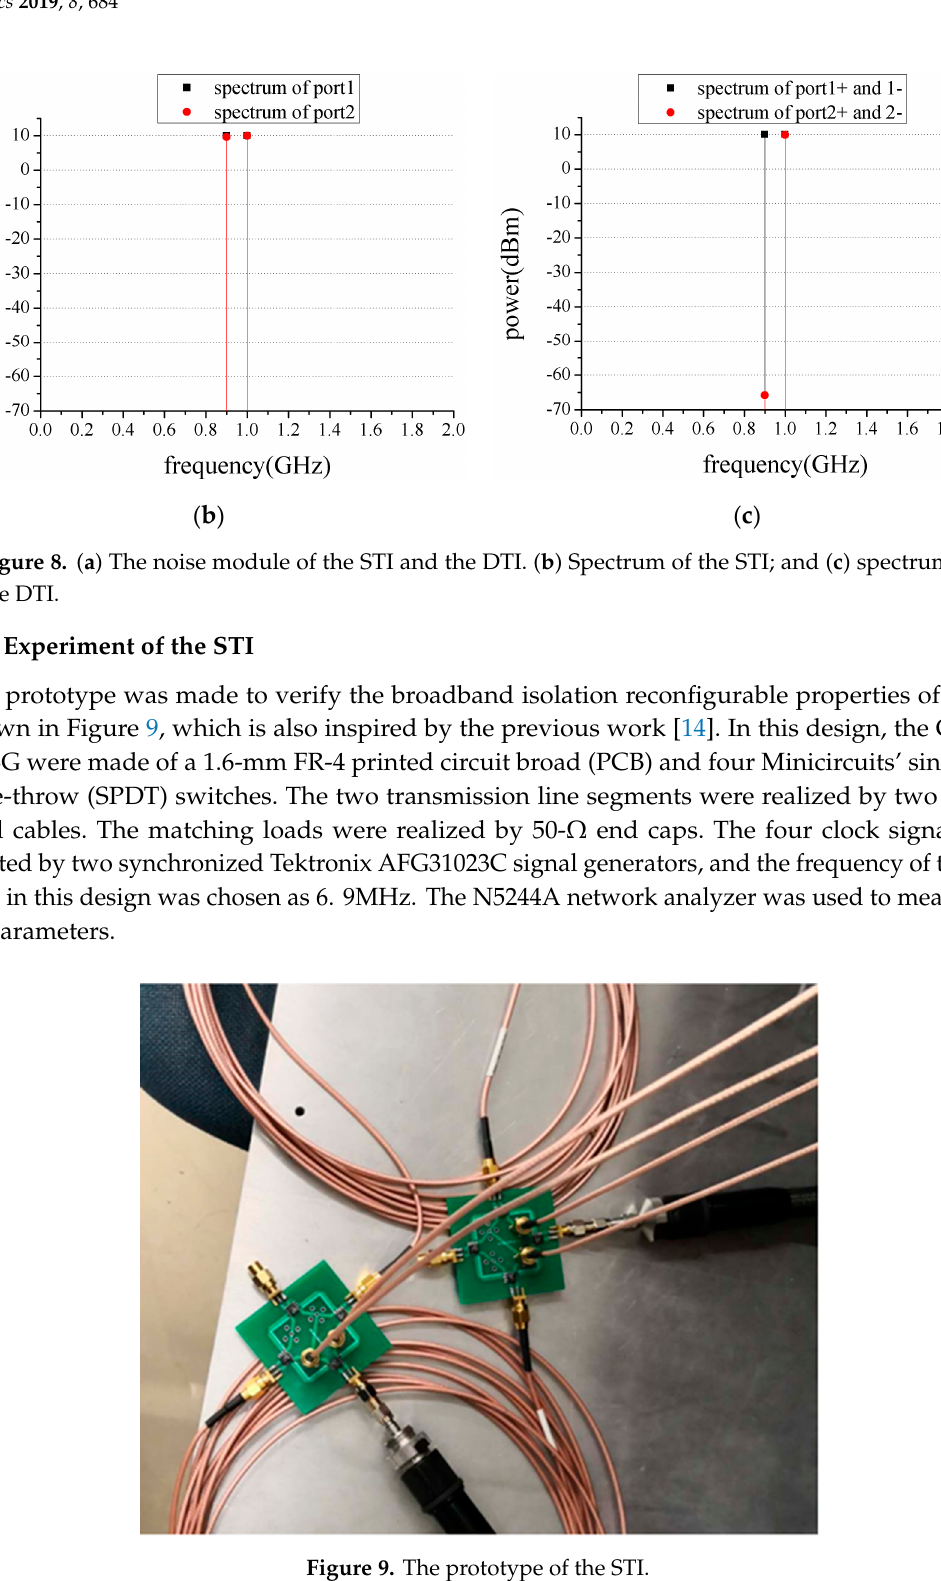
( b ) Figure 10. The measurement results with ( a ) clock signals unchanged and with ( b ) changed clock signals. For comparison, the simulated and measured results of the STI are shown in Figure 11. In the observation frequency range from 100 MHz to 1 GHz, the simulated S 21 is higher than the measured S 21 , and the average deviation is 12 dB. The simulated S 12 is lower than the measured S 12 , and the average deviation is 21 dB. The delay error of the coaxial cables and the duty cycle error of the clock signals have significant effects on the insertion loss and return loss. The insertion loss can be reduced by using sub-nanosecond switches and high-quality clock signals.